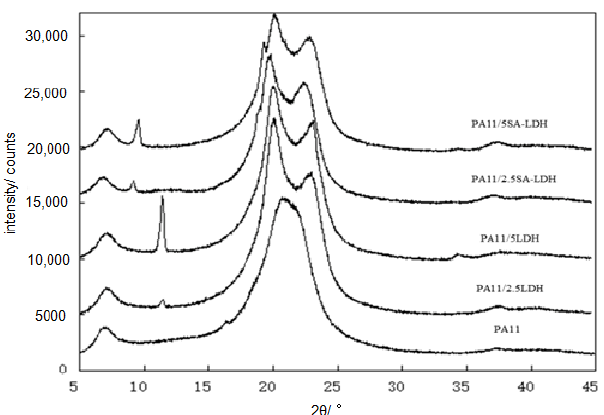
Figure 3. XRD patterns of PA11 and its composites.